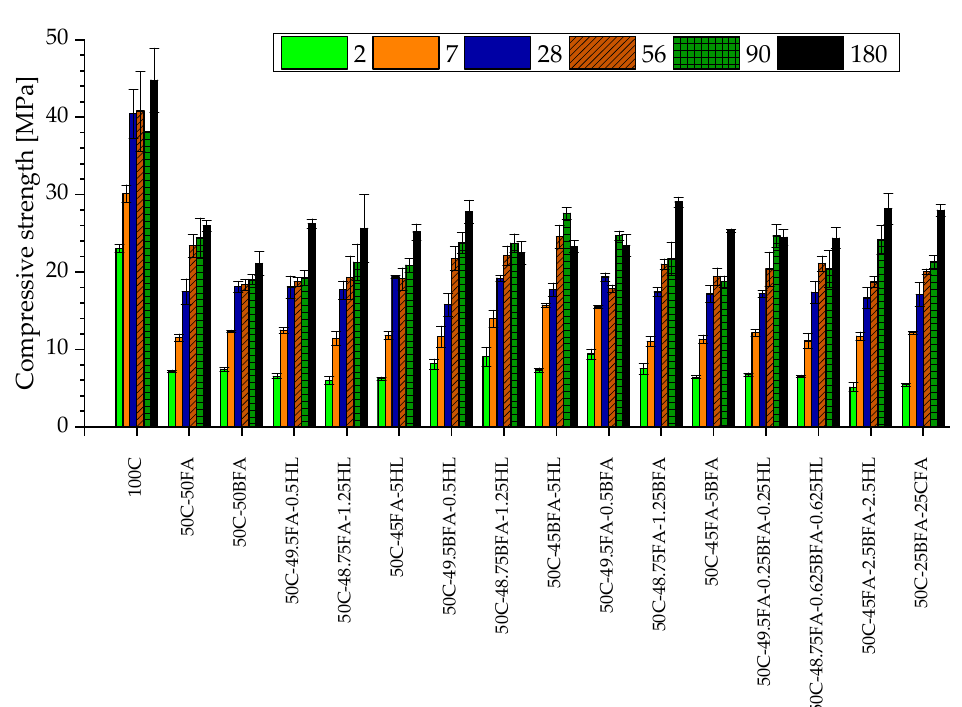
Figure 6. Evaluation of compressive strength values of mortars with the curing period for 2, 7, 28, 56, 90, and 180 of curing .